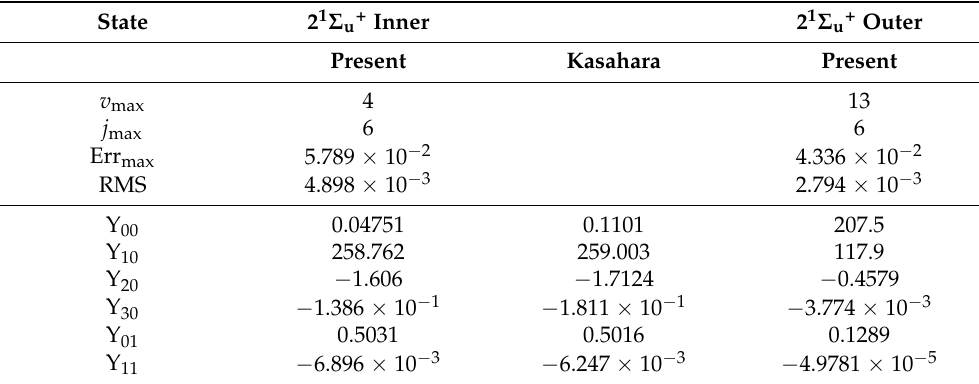
Table 4. Spectroscopic constants of 2, 3, 4 and 5 1 Σ u+ states of 7 Li 2 for Dunham